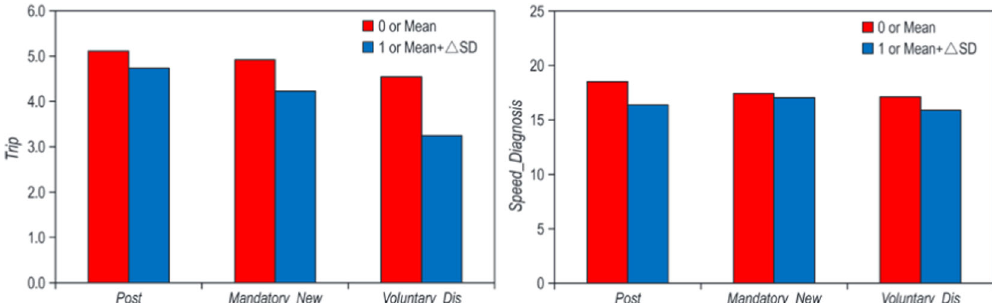
Fig. 4 Impact of government disclosure on behaviors of the infected. Post is an indicator that equals 1 after a province entered the Category I public health emergency regime and 0 before. Mandatory_New is the daily new con fi rmed cases for a province. Voluntary_Dis is the number of independent disclosures by a province ’ s Center for Disease Control (CDC). For indicator Post, the red column represents value for the number of trips (speed of diagnosis) when Post is 0 and the blue column represents value for the number of trips (speed of diagnosis) when Post is 1. For continuous variables Mandatory_New and Voluntary_Dis, the red column represents value for the number of trips (speed of diagnosis) when they are at their mean and the blue column represents value for the number of trips (speed of diagnosis) when they are at their mean plus one standard deviation.